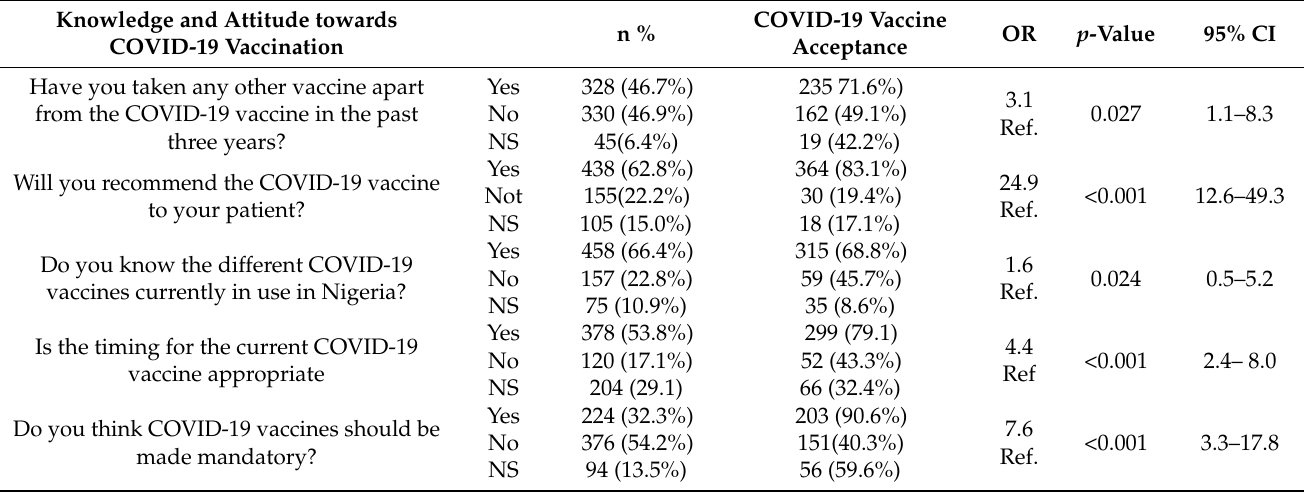
Table 2. Multinomial logistic regression of COVID-19 vaccine acceptance and attitudes/knowledge of respondents towards COVID-19